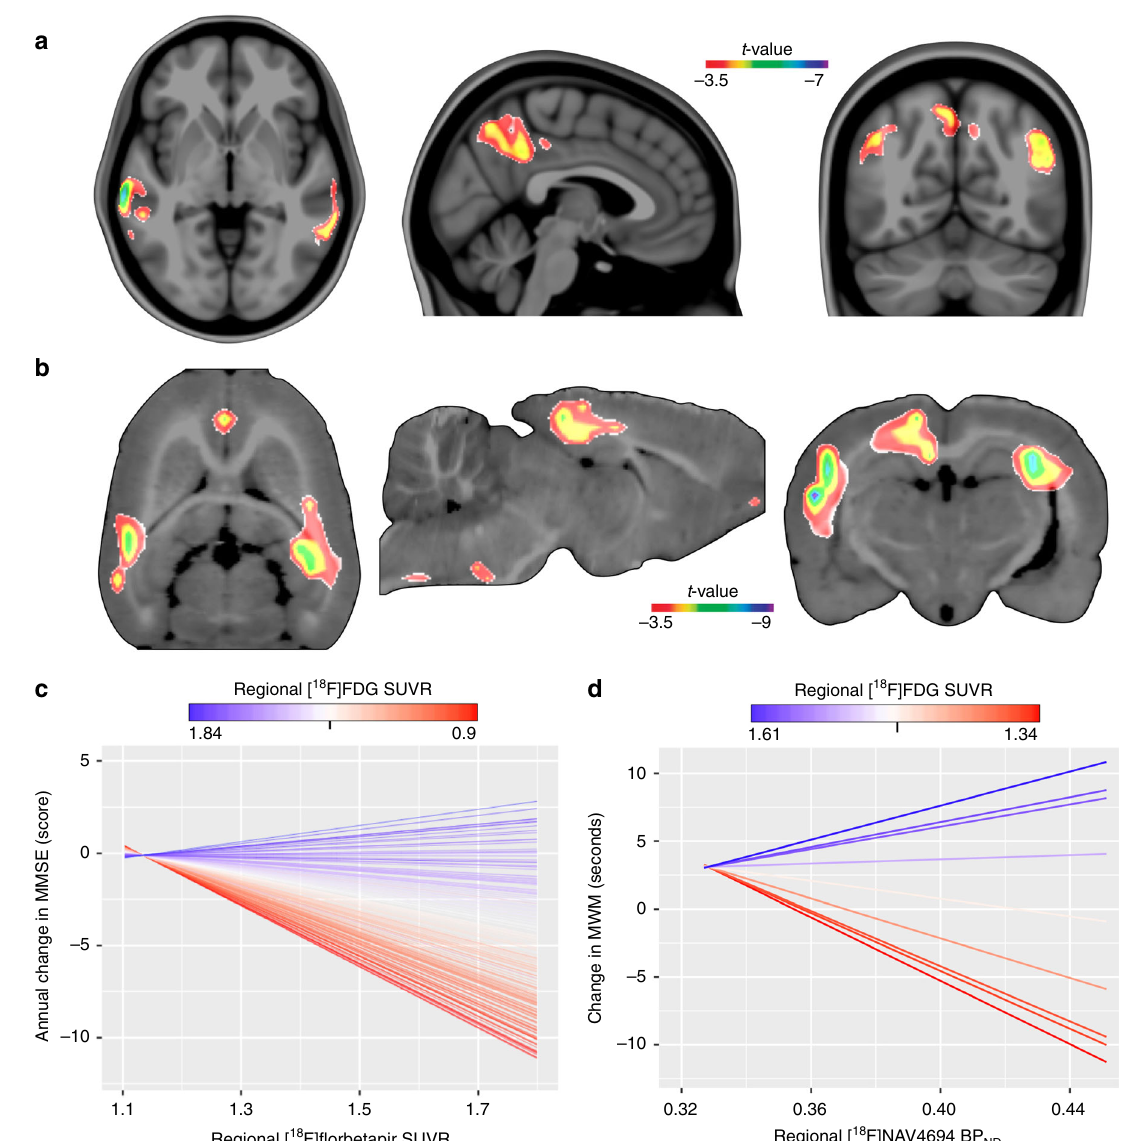
Fig. 6 The synergy of amyloid- β (A β ) with overlapping hypometabolism drives cognitive decline. a The parametric map shows signi fi cant interactive effects at a voxel level between A β and glucose uptake on MMSE worsening over up to 5.6 years in the precuneus, posterior cingulate, inferior parietal, and lateral temporal cortices in MCIs A β positive ( n = 170). The aforementioned interaction was not signi fi cantly associated with cognitive decline in CN A β positive. b In transgenic A β rats, signi fi cant voxel-wise interactive effects between A β and glucose uptake on MWM worsening over 8 months were found in the retrosplenial cortex, which corresponds to the posterior cingulate in humans, inferior parietal, and mediobasal and lateral temporal cortices. The plots show the graphical representation of the interaction in ( c ) MCIs A β positive (see Supplementary Movie 2) and in ( d ) transgenic A β rats, where each parallel line represents a single subject. For longitudinal changes in MMSE and MWM, lower values indicate greater impairment. Parametric images were FWER corrected at P < 0.05 and adjusted for global A β , age, gender, education, APOE ε 4 status, p-tau, gray matter density, and follow-up duration in humans, and adjusted for global A β , age, gender, and gray matter density in